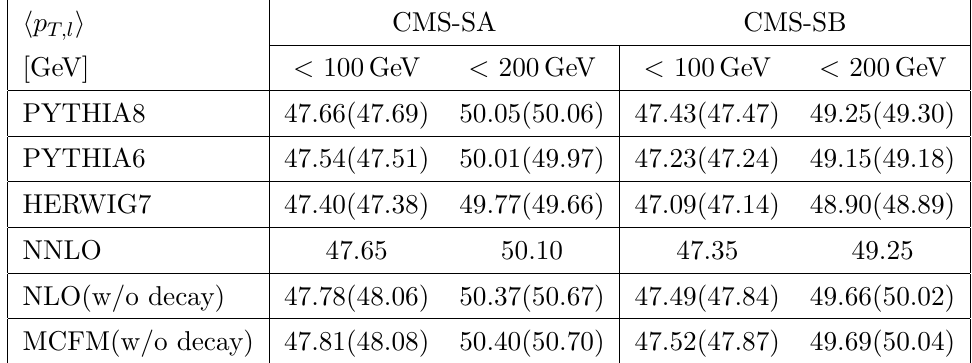
Table 6 . Average transverse momentum of the charged lepton within the two fiducial regions, comparing predictions at fixed-order and those from various event generators in the 5FS for LHC 13 TeV. Numbers in parenthesis correspond to MC predictions without including hadronization or fixed-order predictions without including QCD corrections in decay of top quark.